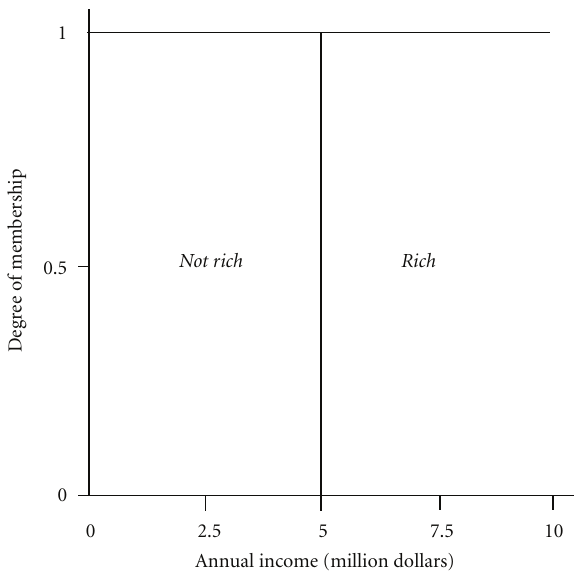
Figure 5: McCain’s crisp sets for rich and not rich .